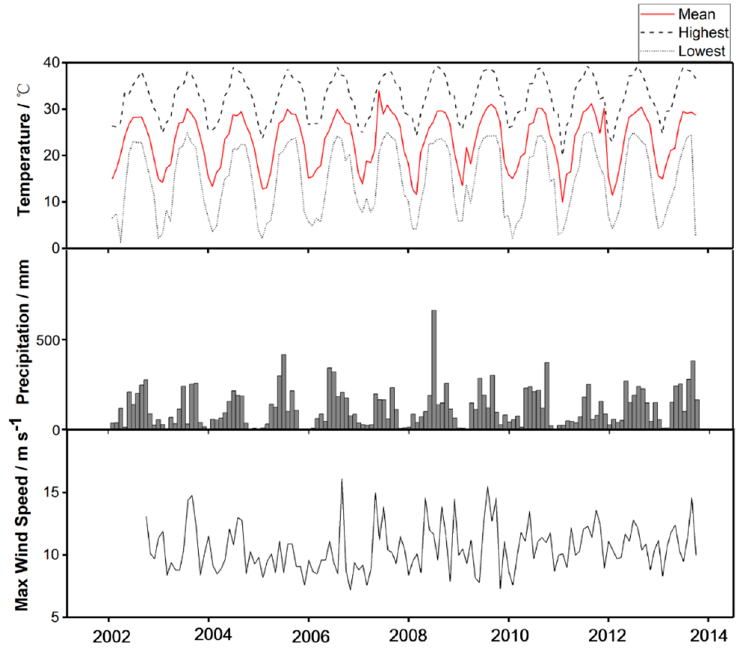
Figure 2. Monthly max wind speed (m · s − 1 , line graph), monthly totals of precipitation (mm; bar graph) and monthly mean, highest and lowest temperature (°C; line graph) for the study site from 2002 to 2014.